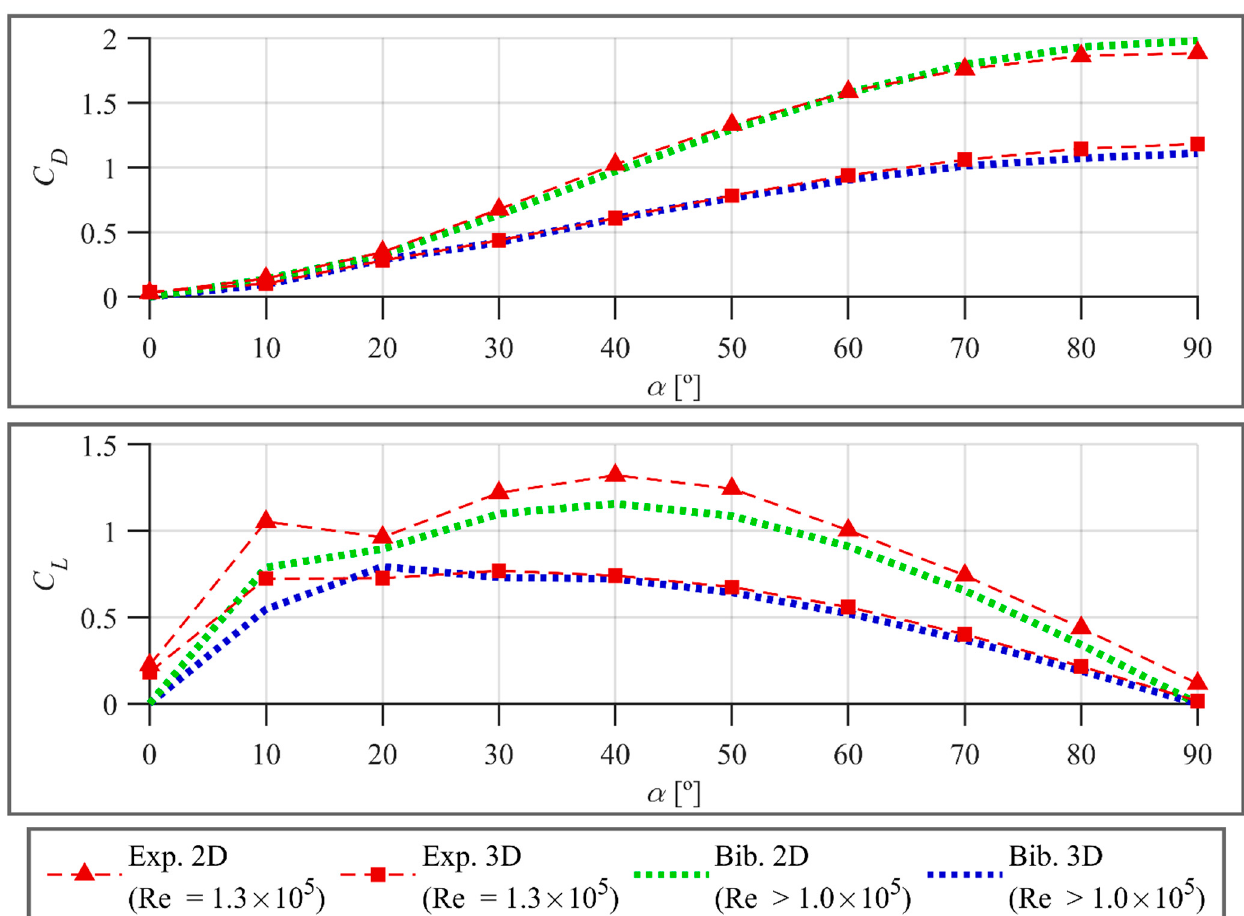
Figure 5. Experimental drag and lift coefficients from 2D and 3D flat plates compared with data from the bibliography.